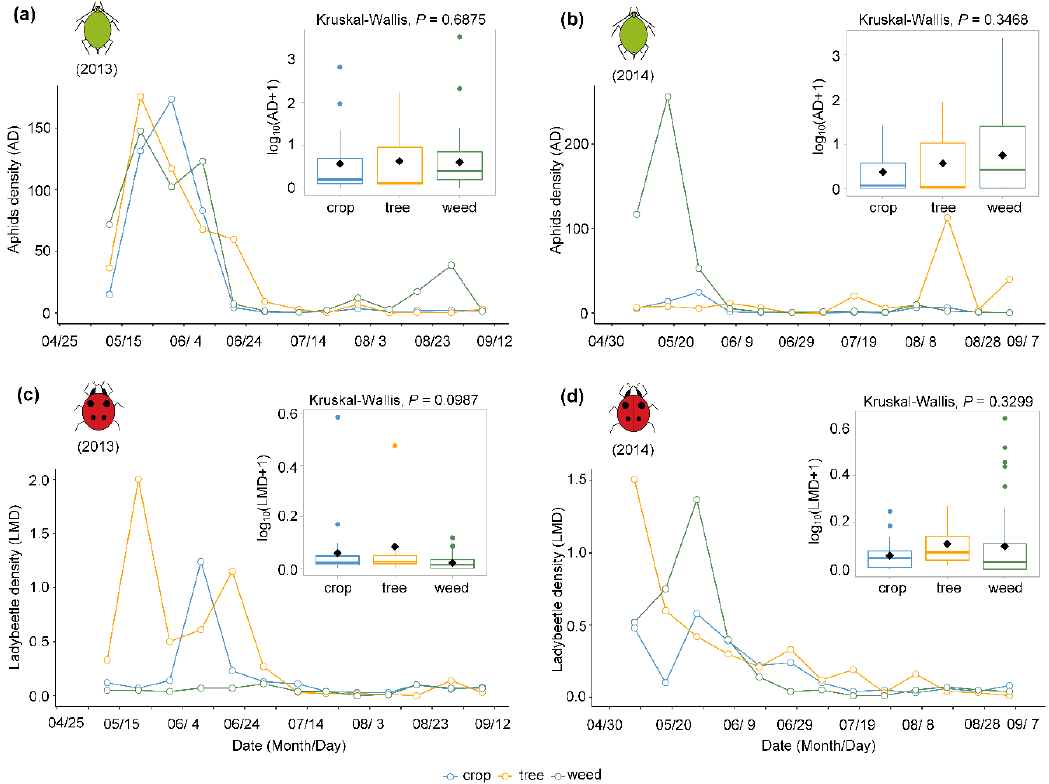
Figure 1. Population dynamics of aphids and ladybeetles on different plant functional groupsatthe field scale in 2013 and 2014. Aphid density (AD) in 2013 ( a ) and 2014 ( b ) and ladybeetle metapopulation density (LMD) in 2013 ( c ) and 2014 ( d ) are the mean values on each sampling date in three plant functional groups. Boxplots nested in the top right corner are the mean values of AD and LMD throughout the whole sampling period. Diamond points with black color in the box are the mean value for each functional plant taxon, whereas the line in each box is the median, and box edges represent the lower (Q1) and upper (Q3) quartiles. The number of plant species of plant functional groups (crops, trees, weeds) was 21, 8, and 49 species in 2013 and 26, 8, and 46 species in 2014, respectively. The p value indicated no significant difference ( p > 0.05) between these plant taxa within the Kruskal–Wallis test.